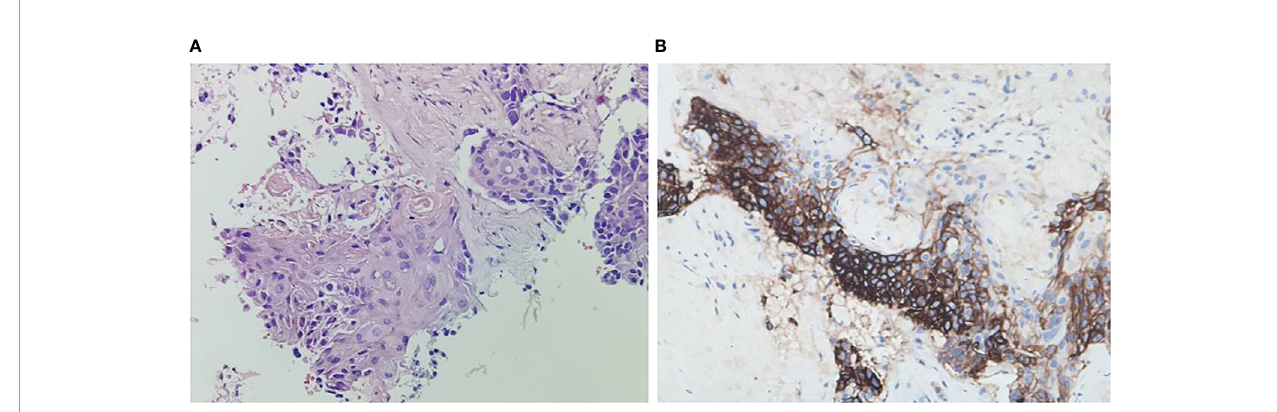
FIGURE 2 | Histopathology of rectosigmoid-junction SCC cancer and immunohistochemistry. (A) H & E stain, original magni fi cation ×200. (B) PD-L1 immunohistochemistry (antibody Dako 22C3), original magni fi cation ×200.